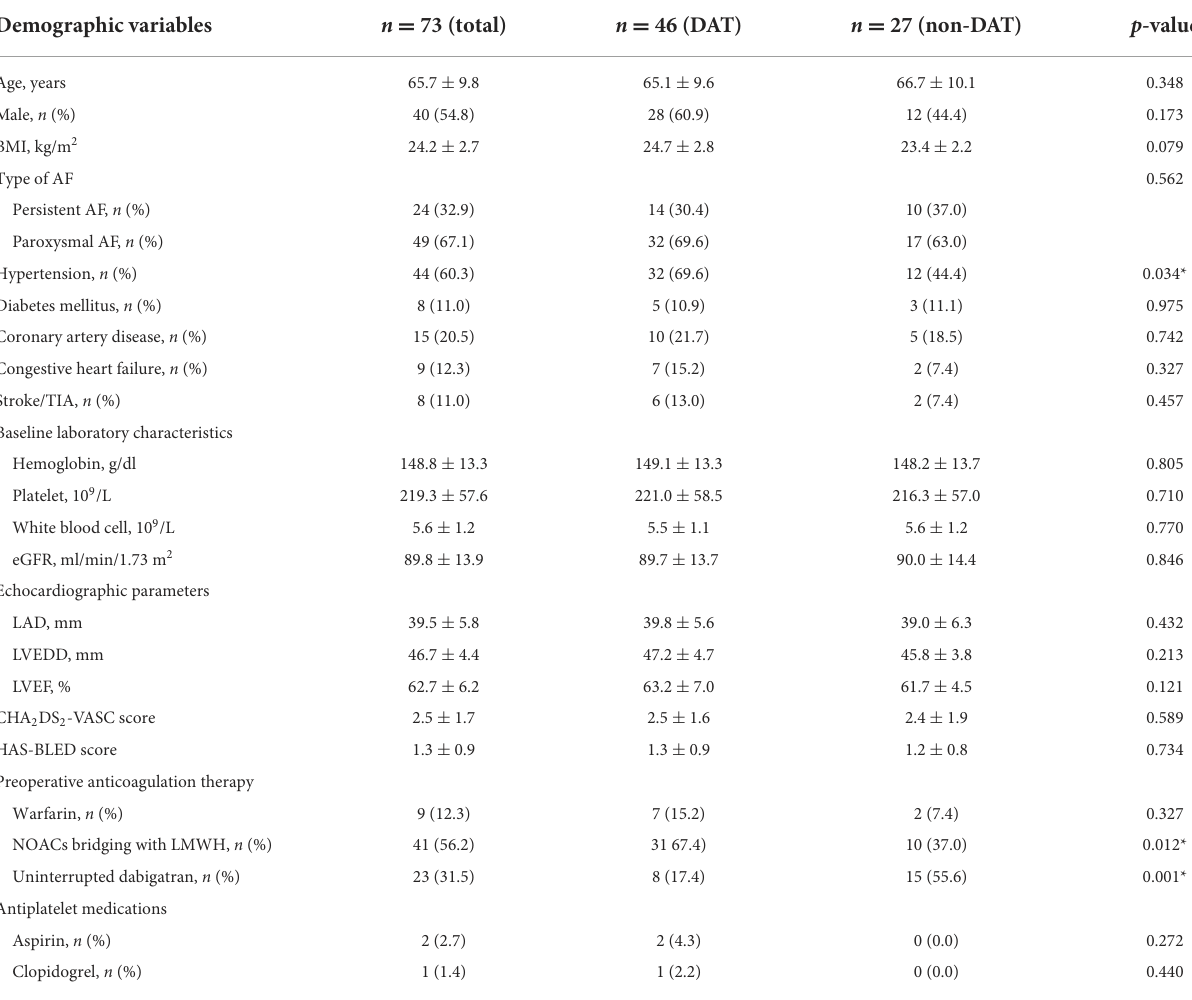
TABLE 1 Baseline characteristics of the study